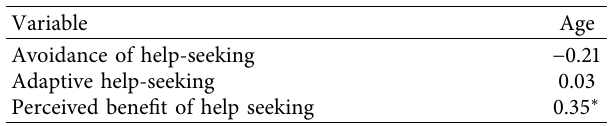
Table 5: Correlation coefficients between age and research help- seeking